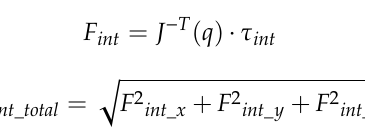
Figure 9. The Unity scene for the testing task.